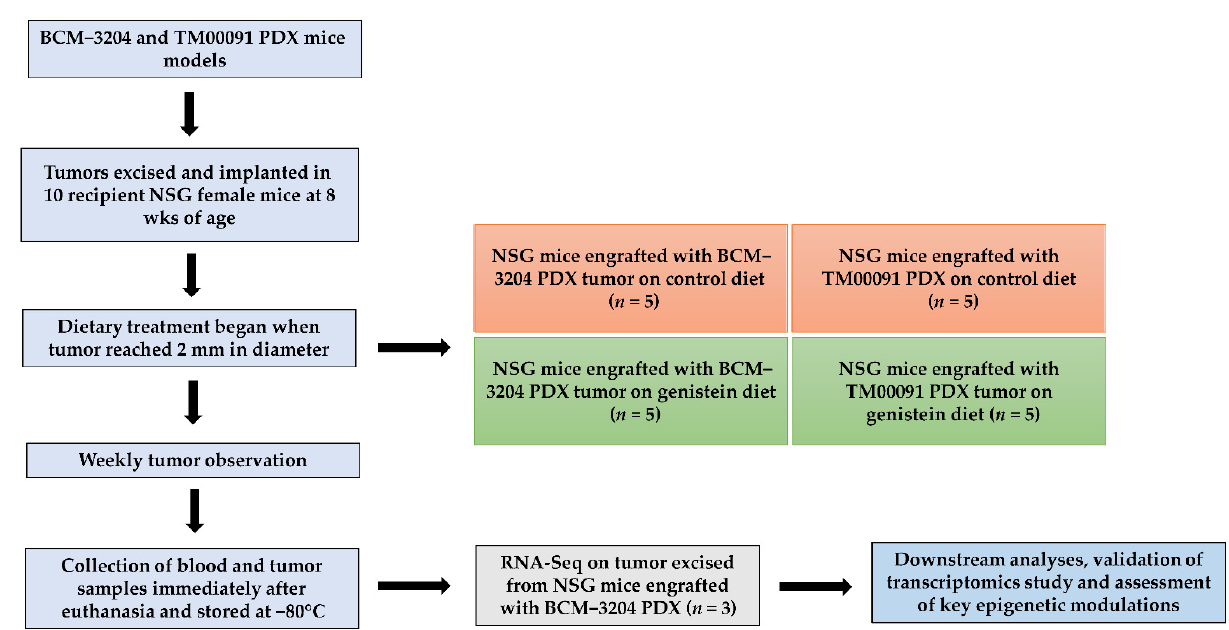
Figure 1. An overview of experimental design of NSG mice bearing BCM − 3204 or TM00091 PDX on GE dietary treatment. The mice were palpated weekly and tumor growth was measured by calipers. Tumor